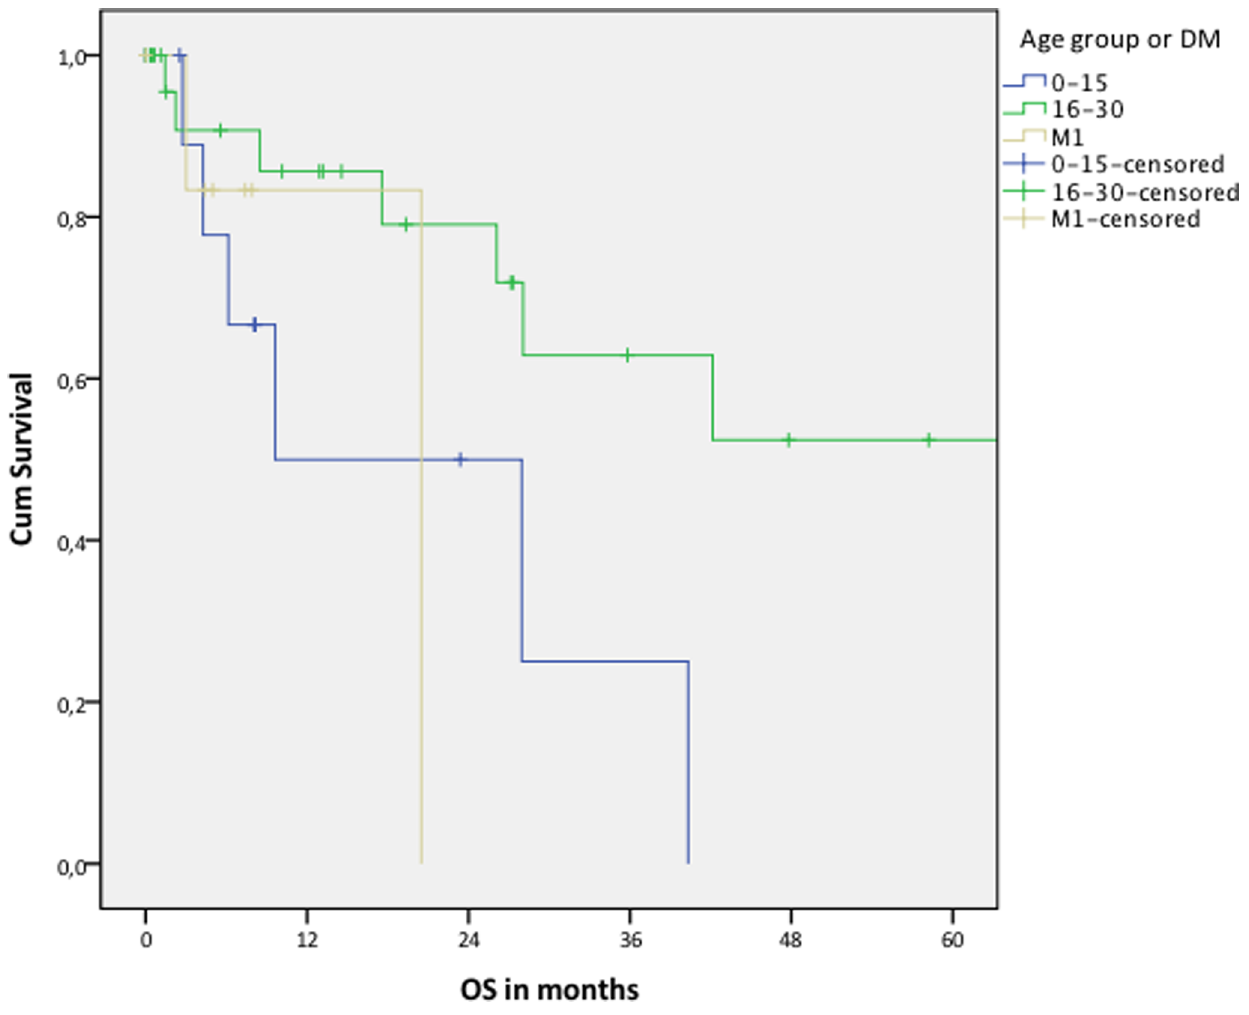
Figure 2. Overall survival: best-case scenario. All patients who were lost to follow up were censored at the moment of last contact (Log rank is p=0.021, when comparing patients without distant metastasis: 0–15 vs. 16–30 year). DM = distant metastasis at diagnosis; OS = overall survival.